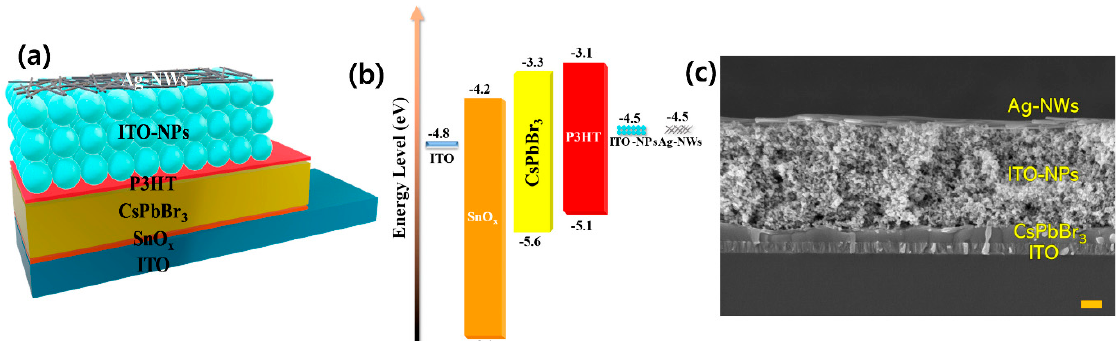
Figure 6. ( a ) Schematic illustration of an AgNW solar cell: constructed n–i–p planar CsPbBr 3 perovskite solar cell architecture, ( b ) designed energy band diagram, and ( c ) SEM image of the cross-sectional device (scale bar = 300 nm). Reproduced from Ref. [47] under the Creative Commons Attribution 4.0 International (CC BY 4.0) License.